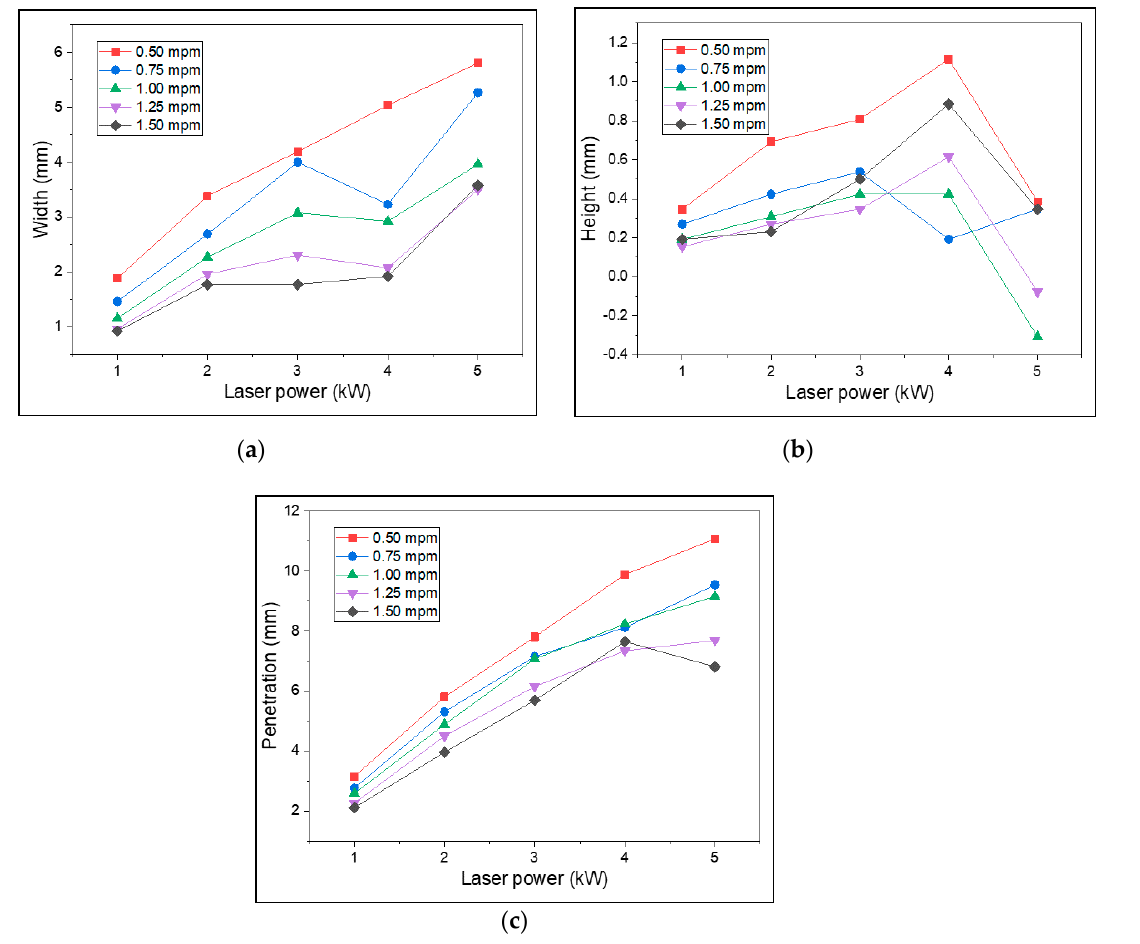
Figure 9. Bead shape according to laser power: ( a ) bead width ( b ) height ( c ) penetration.